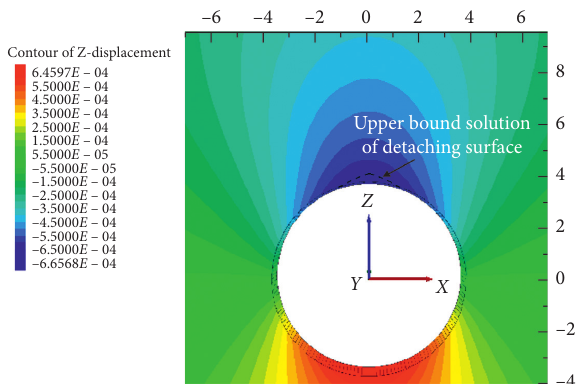
Figure 4: Contour of vertical displacement of tunnel roof under steady seepage conditions of numerical simulation (m).